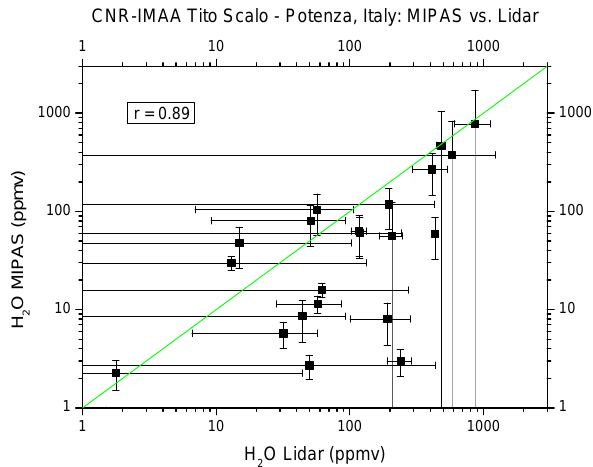
Fig. 19. Correlation between H 2 O mixing ratios measured by MIPAS and 12 lidar soundings performed by the CNR-IMAA in Potenza between July 2002 and February 2004. Green line denotes the 1:1 diagonal. A correlation coefficient r is calculated for all data points.